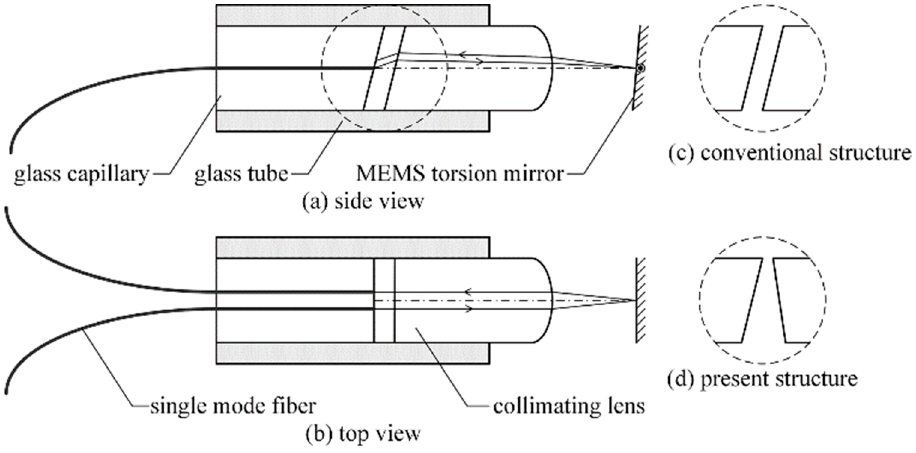
Figure 1. Structure of the variable optical attenuator (VOA) based on a MEMS torsion mirror.